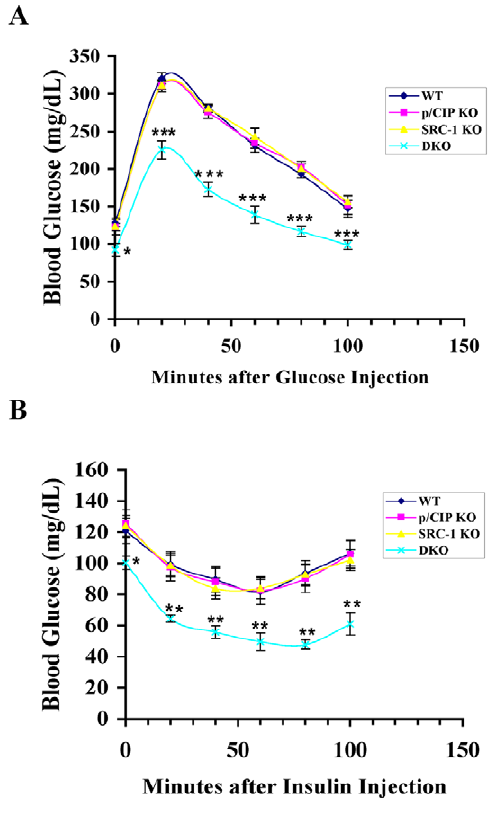
Figure 1. The DKO mice are more insulin sensitive in glucose and insulin tolerance tests (GTT and ITT respectively). A and B, Three-month old male mice (5 for each genotype) were fasted for six h, and intraperitoneally (ip) injected with a bolus of glucose (1.5 mg glucose/g body weight for GTT in panel A) or insulin (0.75 mU/g body weight for ITT in panel B). Blood glucose levels of mice were measured before and after injection with a glucometer at 20 min intervals. All results are presented as means 6 S.E.M. * p , 0.05, ** p , 0.005, and *** p , 0.0005.